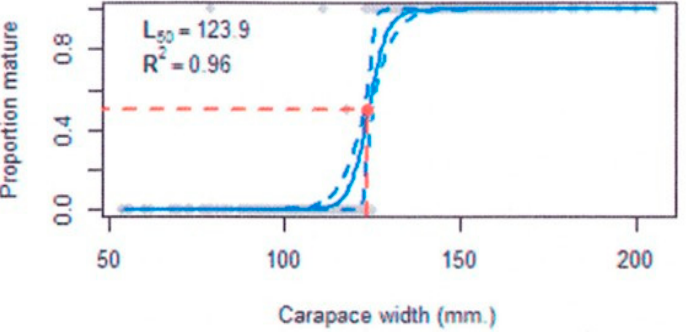
Figure 7. The mean size at maturity (L 50 ) of Callinectes sapidus females in the period November 2020– October 2021 in Monolimni Lagoon and the adjacent coastal area, according to frequentist regres- sion.